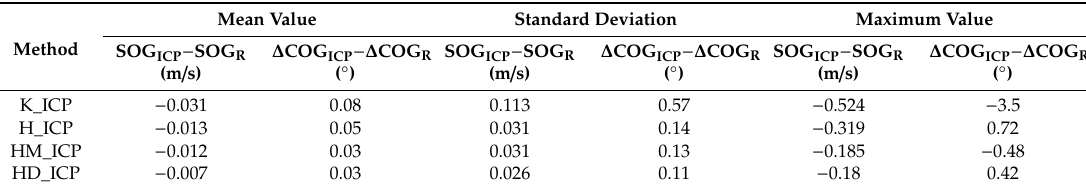
Table 1. Summary of comparative statistical parameters.